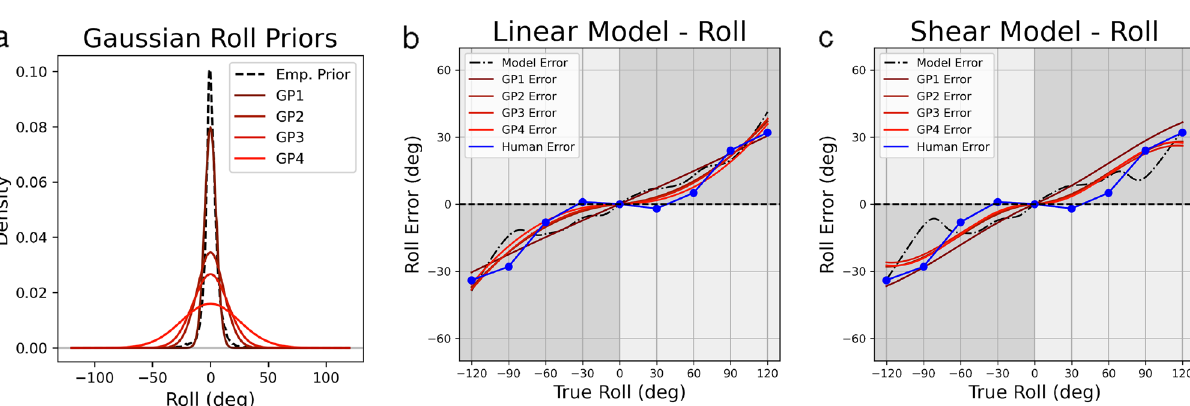
Figure 6. Head roll perception error modeling using Gaussian priors. Gaussian priors are plotted in ( a ) in red, while the empirical roll prior is plotted in dashed black. Improved performance is seen when using these as priors in the linear model ( b ) and the shear model ( c ). Model predictions using a given prior are plotted in dashed black and red, while psychophysical roll perception data from previous work are plotted in dark